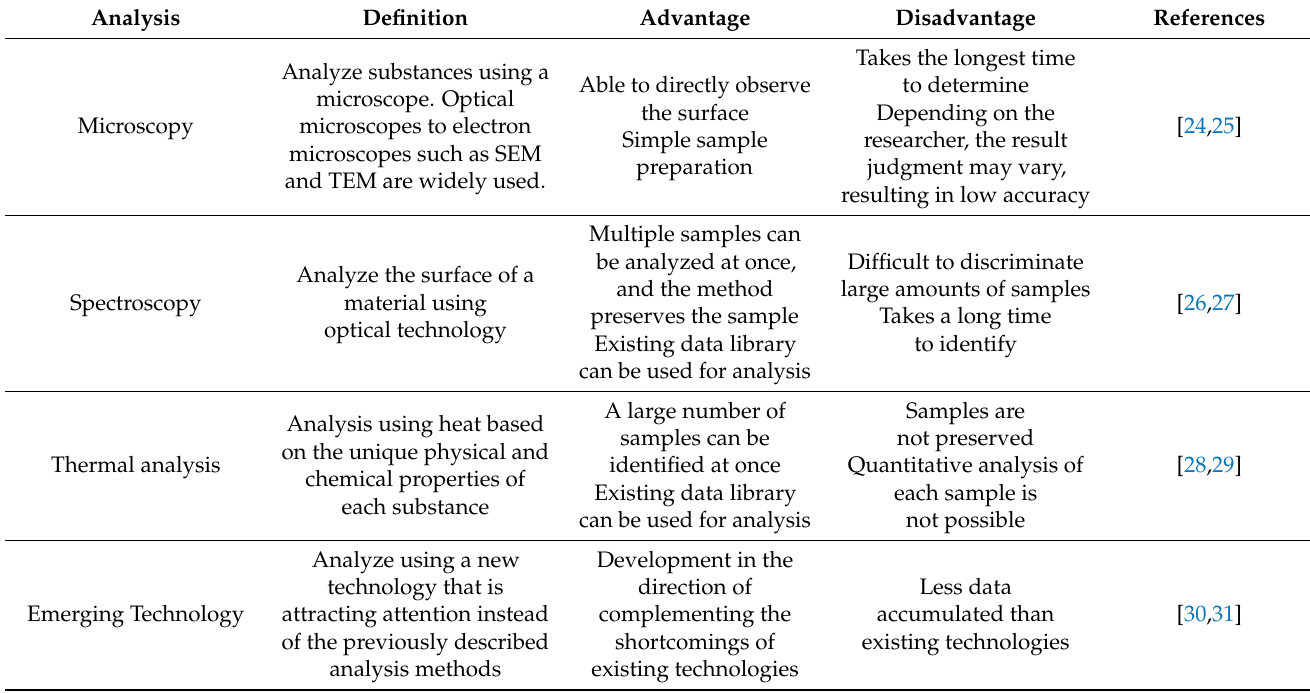
Table 1. Summary of technically analyzing